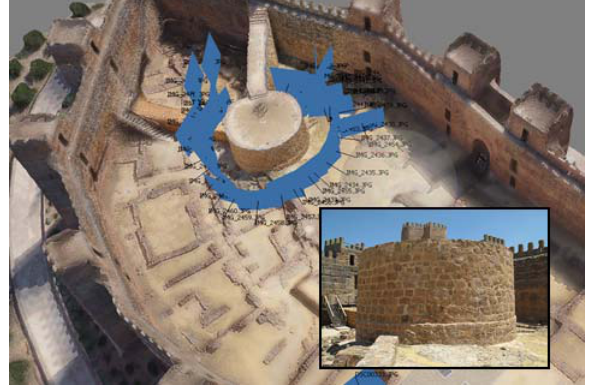
Figure 15. Additional terrestrial network for surveying the inner walls in the ward. Camera was a Canon Powershot G10.